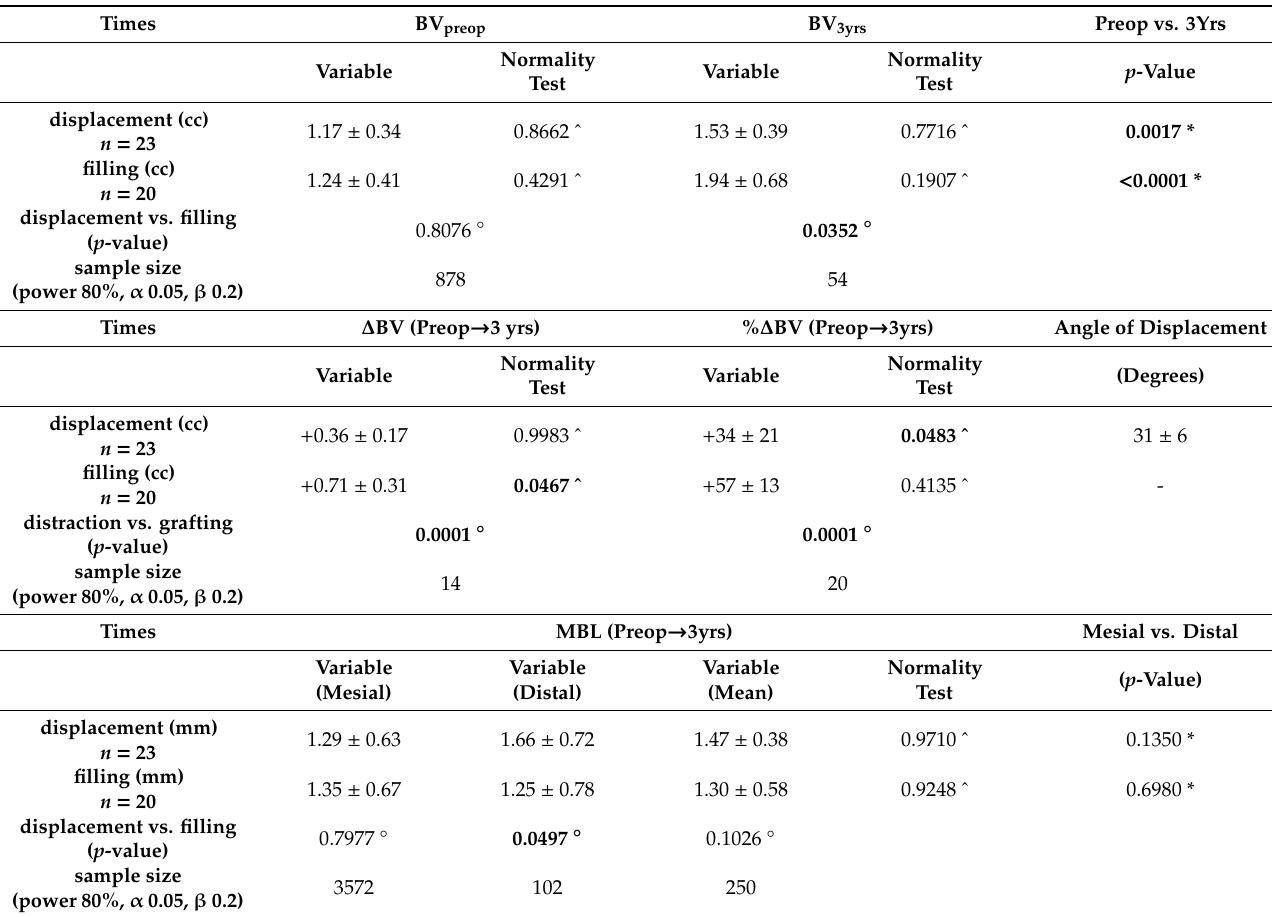
Table 1. Mean and standard deviation of volume at the preoperative (preop) stage and at the 3-year survey (3yrs) of the alveolar bone, and their di ff erence, ∆ BV (with % ∆ BV as its percentage) from the preoperative stage to the 3-year survey (preop → 3yrs) in volume of interest